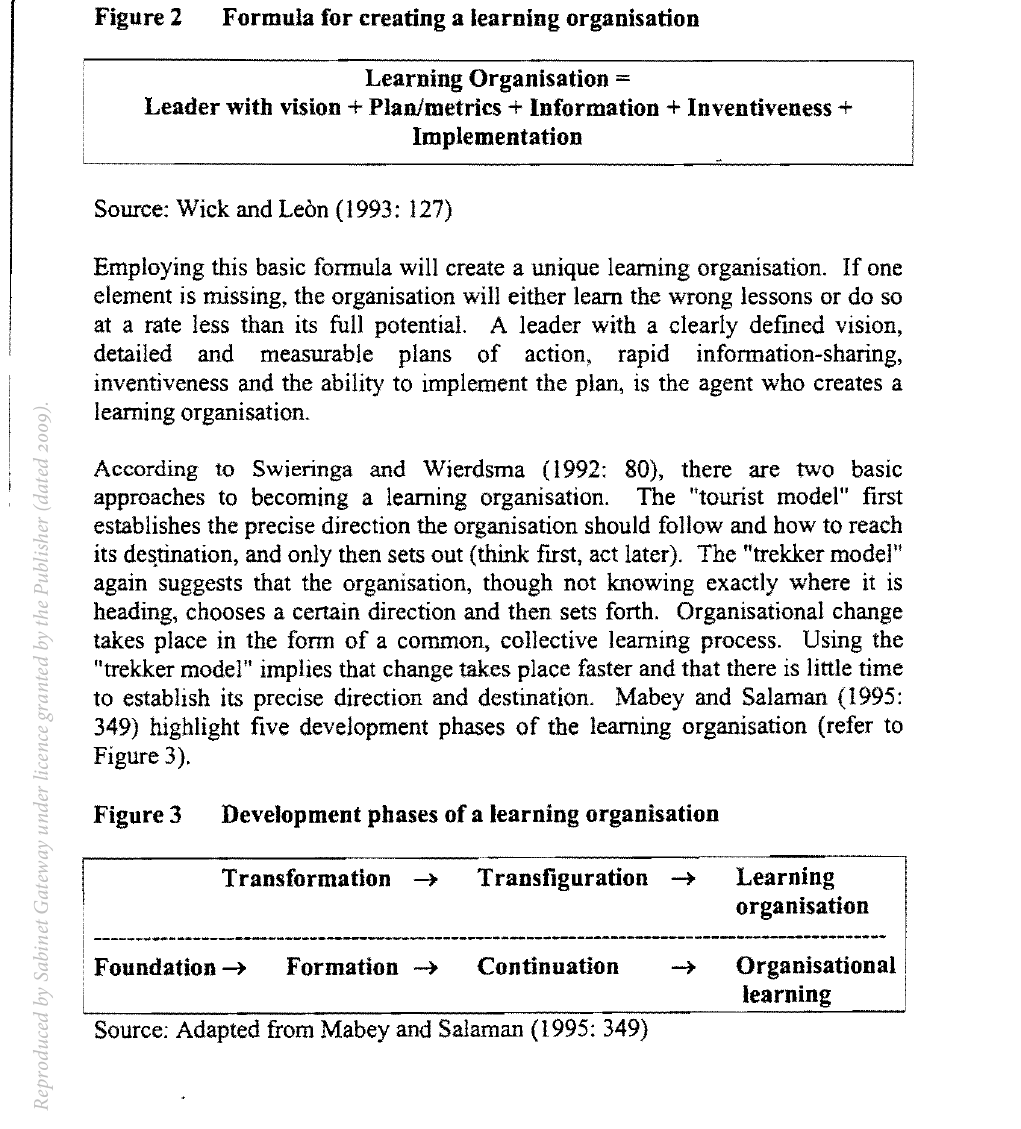
Development phases of a learning organisation Transformation ~ Transfiguration ~ Learning organisation Continuation